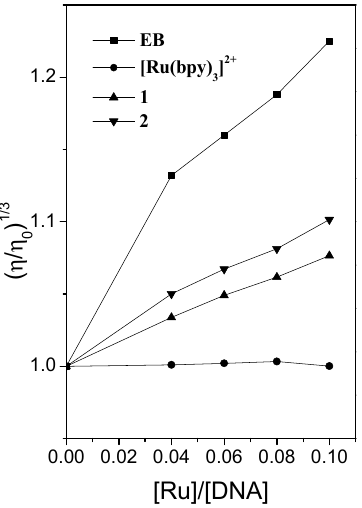
Figure 2. The viscosity of DNA (0.25 mM) after incubation with different concentrations of 1 ( ▲ ), 2 ( ▼ ), [Ru(bpy) 3 ] 2+ ( ● ), and EB ( ■ ). Emission titration experiments were also used to prove strong DNA interaction with two complexes by adding DNA into complex solutions. The results were shown in Figure 3. Upon excitation at 450 nm, obvious luminescence was observed for 1 and 2 at 636 and 648 nm, respectively. In the presence of CT-DNA (0–120 μ M), the emission spectra 0.00 0.02 0.04 0.06 0.08 showed enhanced luminescence with the I / I 0 ratio of 1.46 or 1.75 for 1 and 2 , respectively. This indicated that they bind to DNA strongly. The π - π stacking interactions between ruthenium complexes and base pairs restrict the mobility of ruthenium complexes and lead to luminescence enhancement [31].